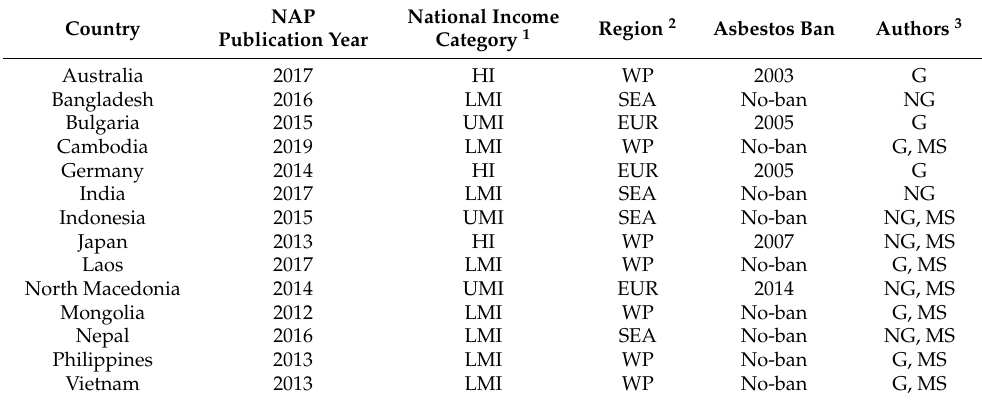
Table 3. Countries that published a National Asbestos Profile, Along With Publication Year and Other